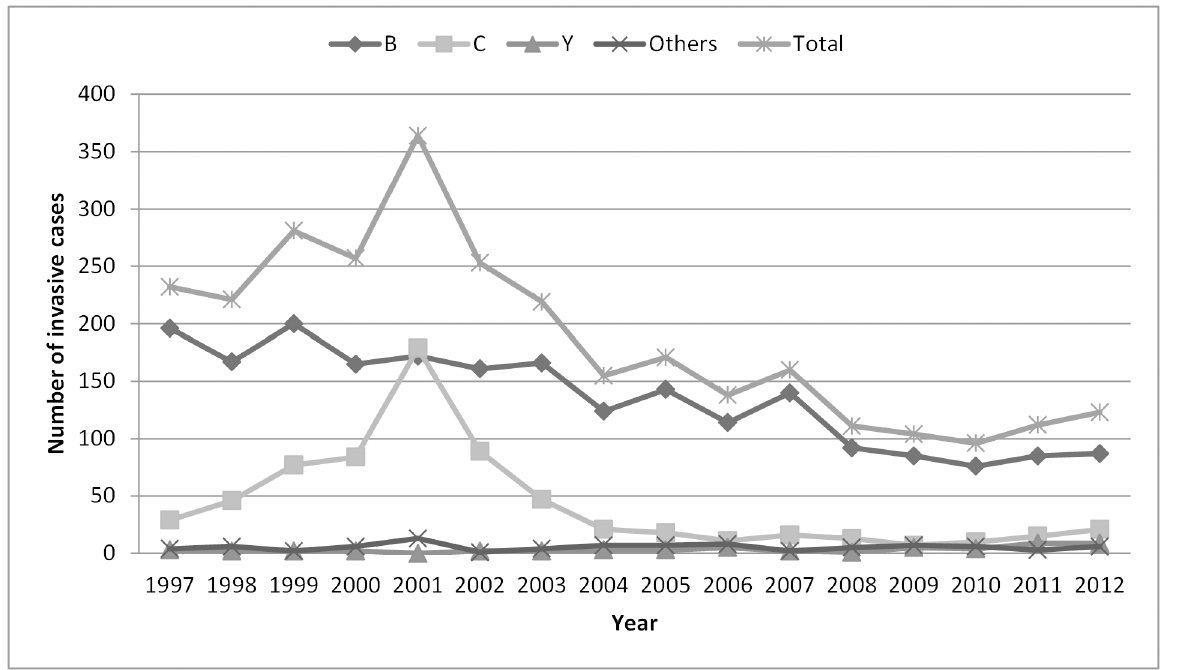
Fig 1. Number of laboratory confirmed invasive meningococcal disease cases in Belgium, 1997 – 2012. Serogroup C vaccination period 2001 – 2004. doi:10.1371/journal.pone.0139615.g001 Table 1. Number of laboratory confirmed invasive Meningococal disease cases in Belgium, 1997 – 2012: number of cases, number of deaths, case fatality rate (CFR), serogroup distribution, and incidence.